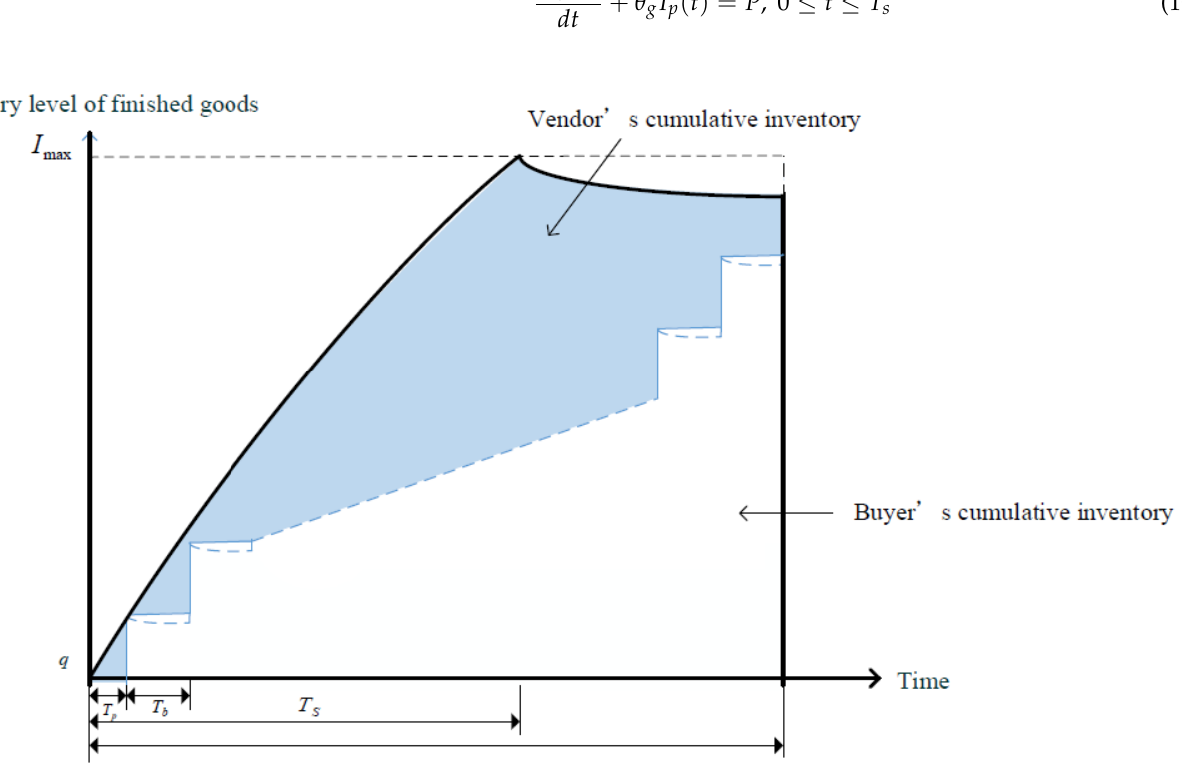
Figure 2. Cumulative inventory for the vendor and buyer.